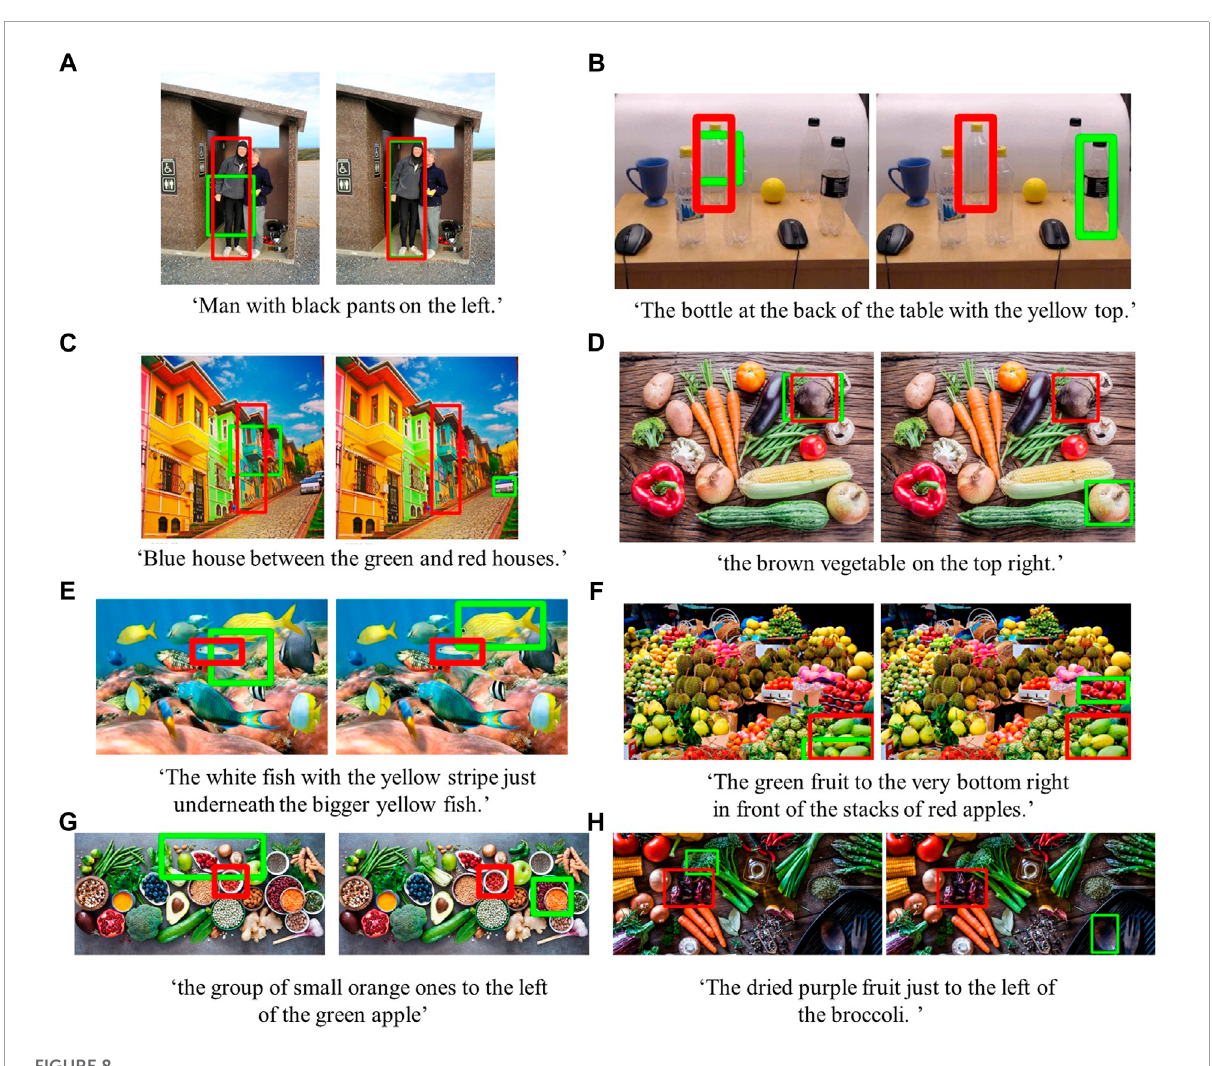
FIGURE 8 Examples of easy (A) , medium (B) , and hard (C,D,E,F,G, H) MTurk dataset images with original expressions collected from AMT workers describing the target objects in red boxes. The green boxes indicate the first proposed candidate object from the Grad-CAM RGB method (on the left) and the MAttNet baseline (on the right). Best viewed in